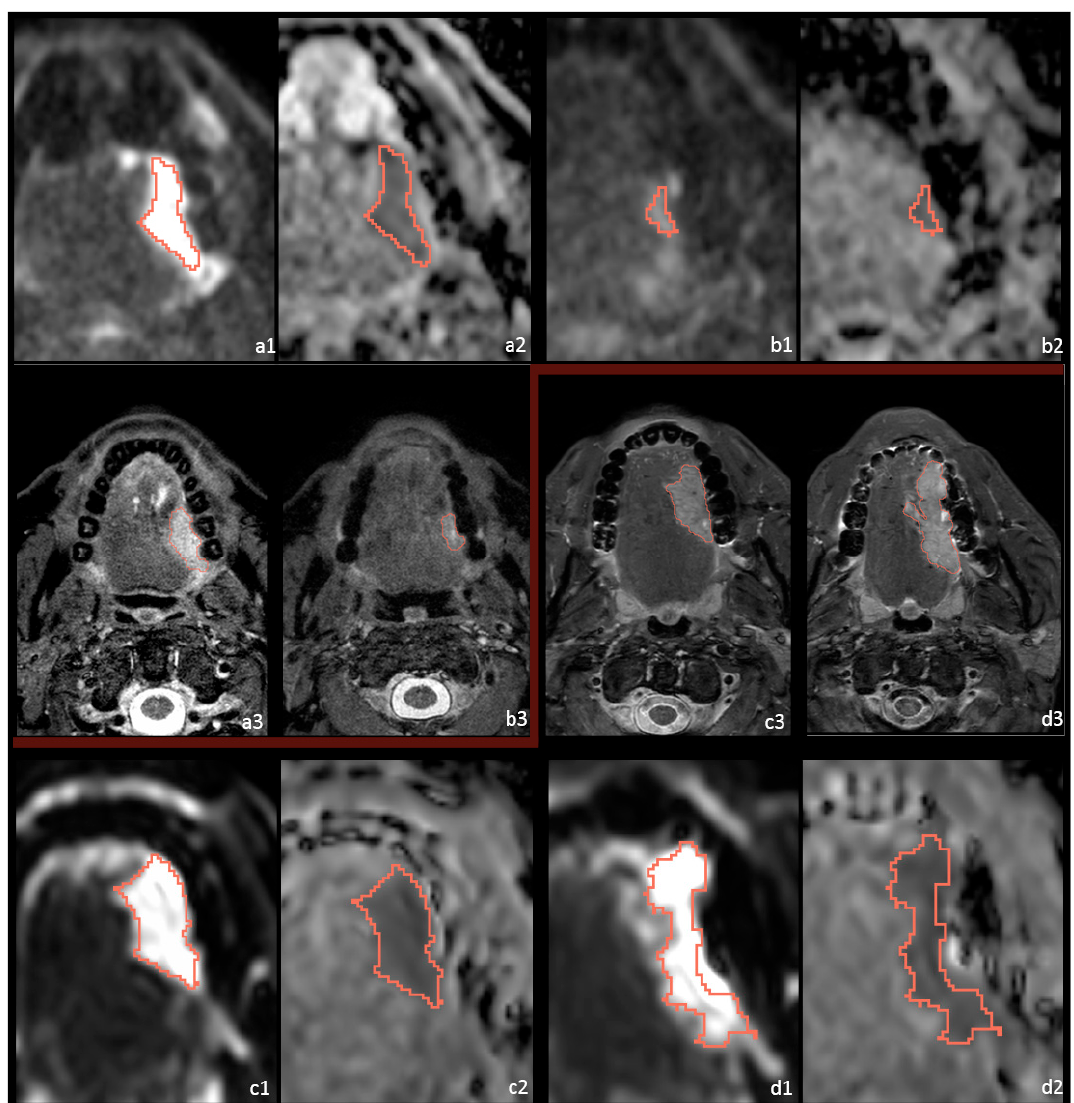
Figure 1. DWI and STIR imaging of 2 patients before and after immunotherapy treatment with different treatment outcomes. Pt39, with a primary cT3N0 HNSCC of the oral cavity, is depicted before (( a1 ) b1000; ( a2 ) ADC-map; ( a3 ) STIR) and after (( b1 ) b1000; ( b2 ) ADC-map; ( b3 ) S = TIR) immunotherapy; this patient had MPR to treatment. Pt37 with a primary cT3N0 HNSCC of the oral cavity is depicted before (( c1 ) b1000; ( c2 ) ADC-map; ( c3 ) STIR) and after (( d1 ) b1000; ( d2 ) ADC-map; ( d3 ) STIR) immunotherapy; this patient had NPR to treatment.